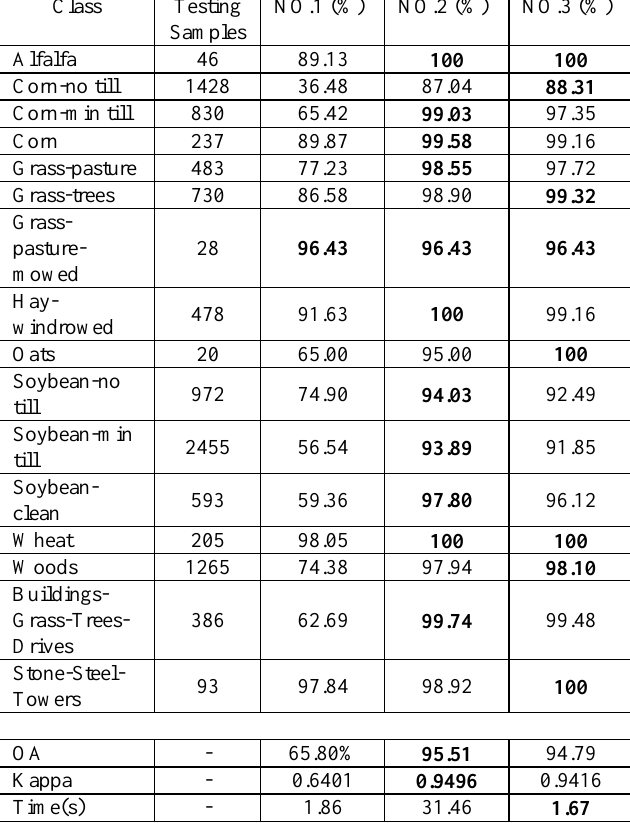
Table 1. Classification accuracy of different